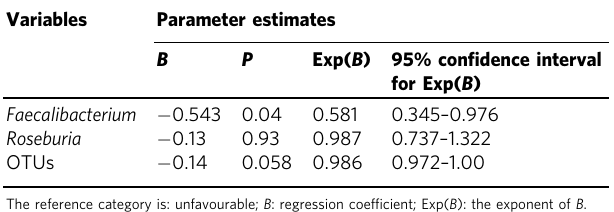
Table 2 Association between different genera and unfavourable